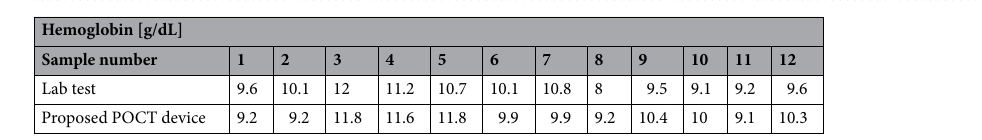
Table 1. Comparison results of Hb levels between lab test and the proposed device. The Hb levels of our device are derived from the Hct results.